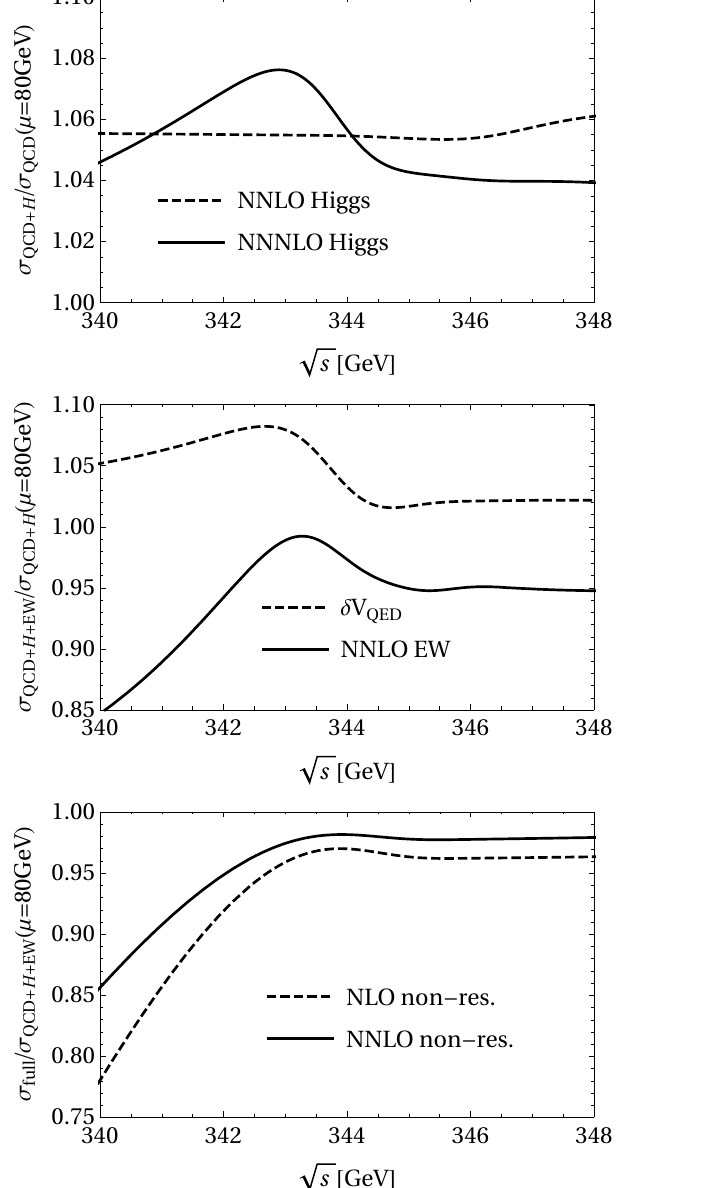
Figure 11 . Relative corrections to the cross section by adding Higgs (top), electroweak (middle) and non-resonant (bottom) e(cid:11)ects